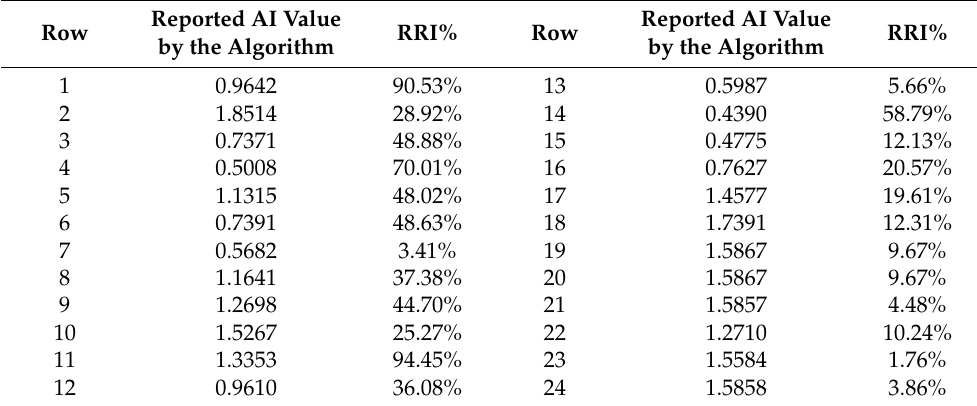
Table 17. The results of RRI% for studies while solved by the proposed method.